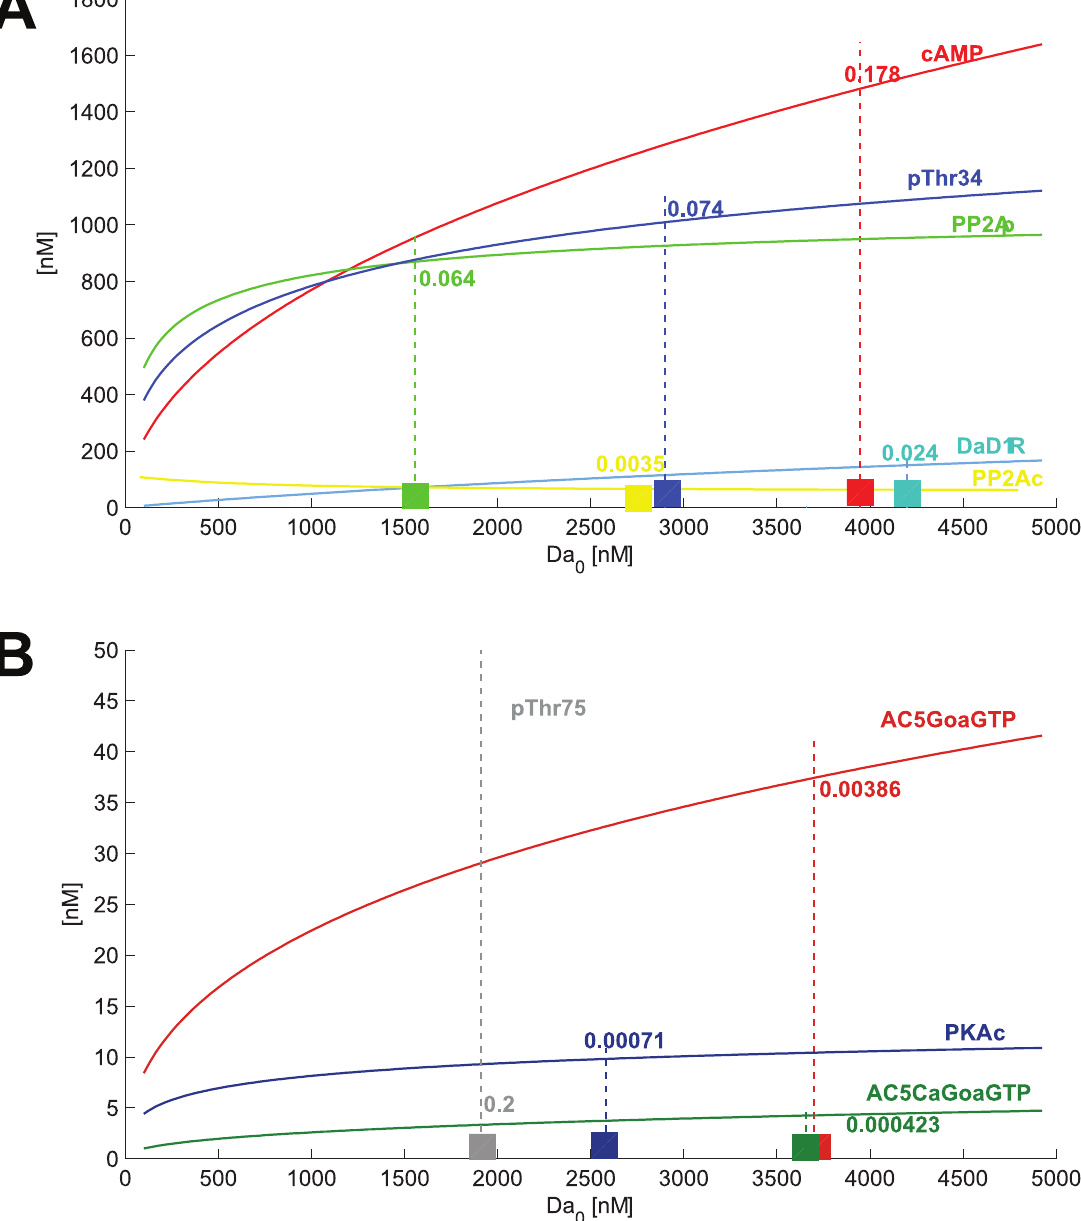
Figure 7. Systemic psfs for input to target. Shown are EC90 and EC10 concentrations as cut-off thresholds for effective signaling by input and the slope values at